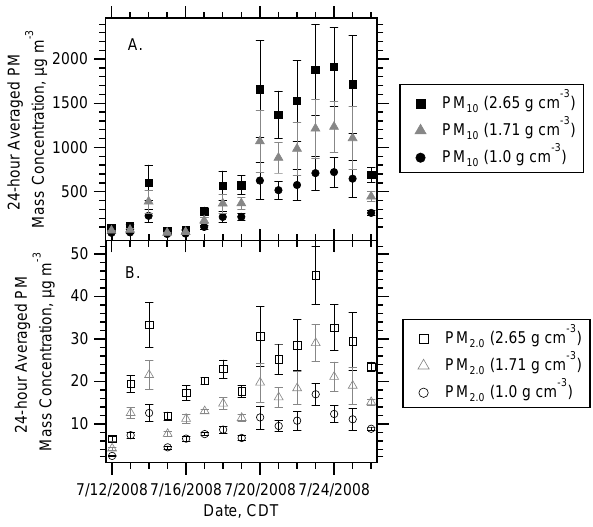
Figure 6. Fig. 6. Daily averaged mass concentrations of PM 10 and PM 2 . 0 at the downwind location are shown in (A) solid and (B) open marks, respectively. Squares, triangles, and circles represent mass concen- tration assuming the particle density is equivalent to that of soil (2.65gcm − 3 ) , dust (1.71gcm − 3 ) , and water (1.0gcm − 3 ) , respec- tively. Error bars represent the standard error of the mean measured concentration over 24h